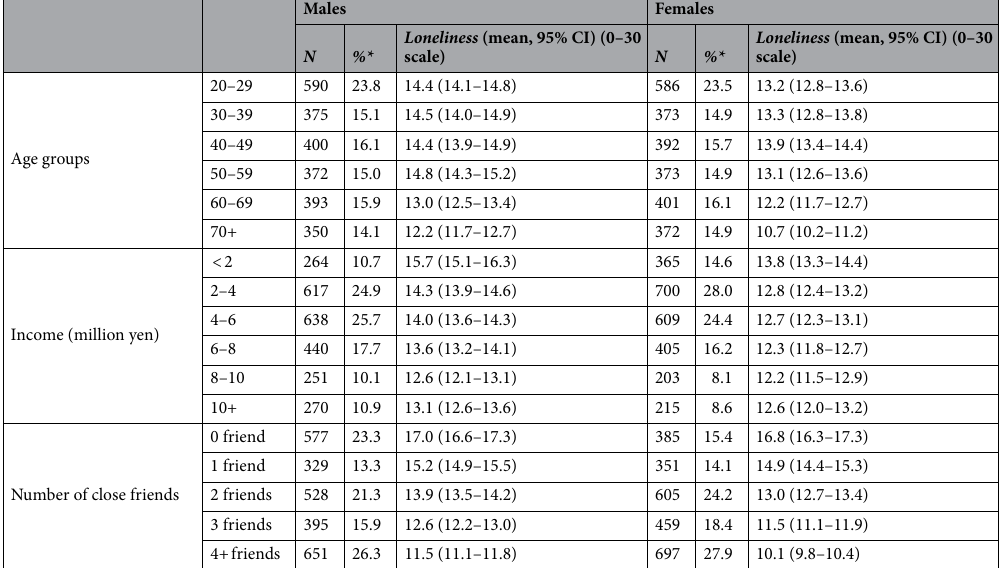
Table 1. Descriptive statistics from the survey data for the primary analysis variables. *The “%” column is calculated as the percent out of the total number of subjects within the gender group ( N = 2480 for males, N = 2497 for females). Combined-gender, full population results are in Supplementary Table S1. 95% confidence intervals (CIs) around the mean are given in parentheses in the loneliness columns.